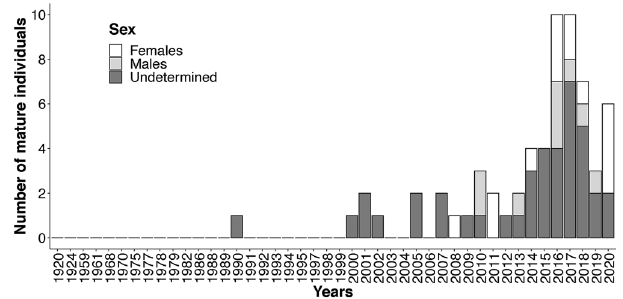
Figure 4. Number of mature loggerhead turtles (70 cm CCL—curved carapace length) observed between 1920 and 2020. When possible, the sex of measured individuals is specified.